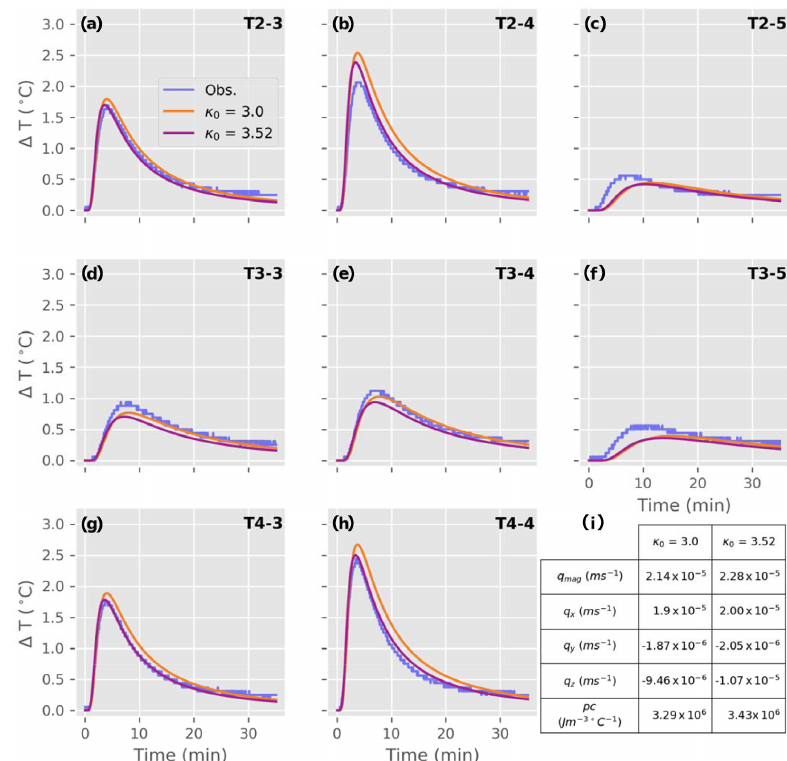
Figure 7. Comparison of the observed (blue line) and modelled breakthrough curves for selected temperature sensors ( T x − x ) when the thermal conductivity, κ 0 , of the sediment has a known value of 3Wm − 1 ◦ C − 1 (orange graph) and when the model is provided with a range of plausible values from 2.5 to 4.5Wm − 1 ◦ C − 1 resulting in 3.52Wm − 1 ◦ C − 1 (red graph).